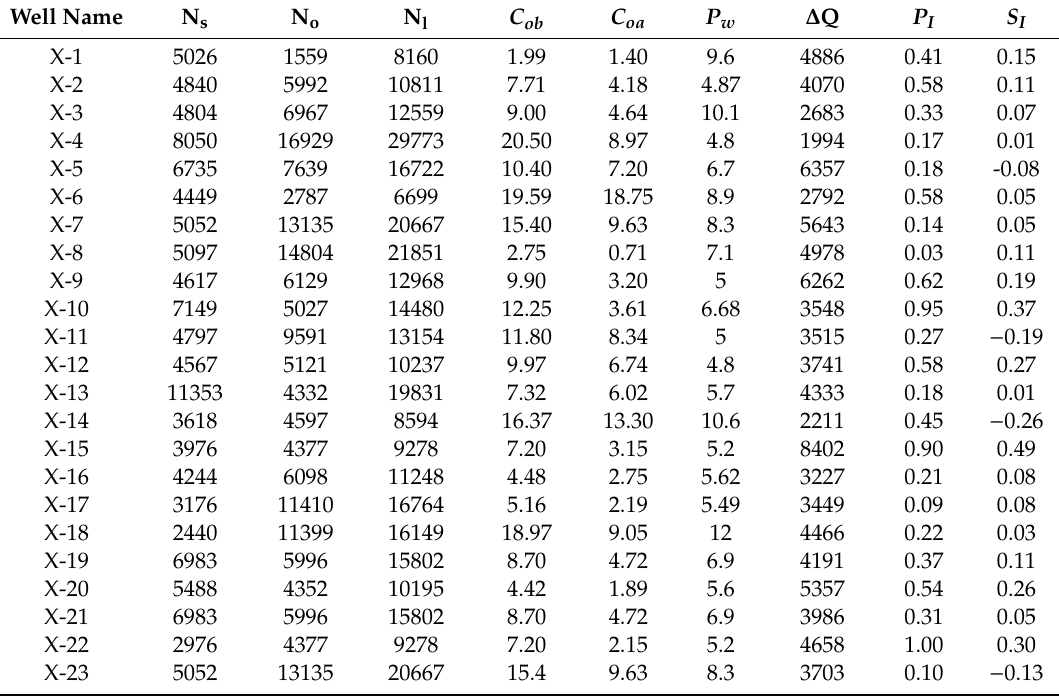
Table A3. Statistical table of production parameters of tight oil wells in the target